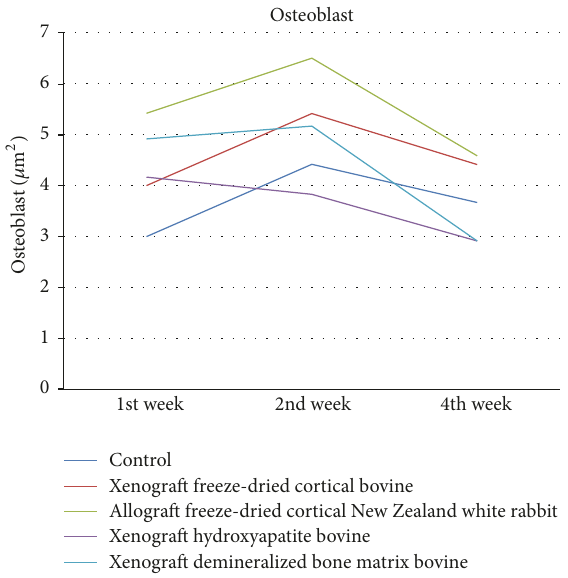
Figure 4: Evaluation of osteoblast/ 𝜇 m 2 .